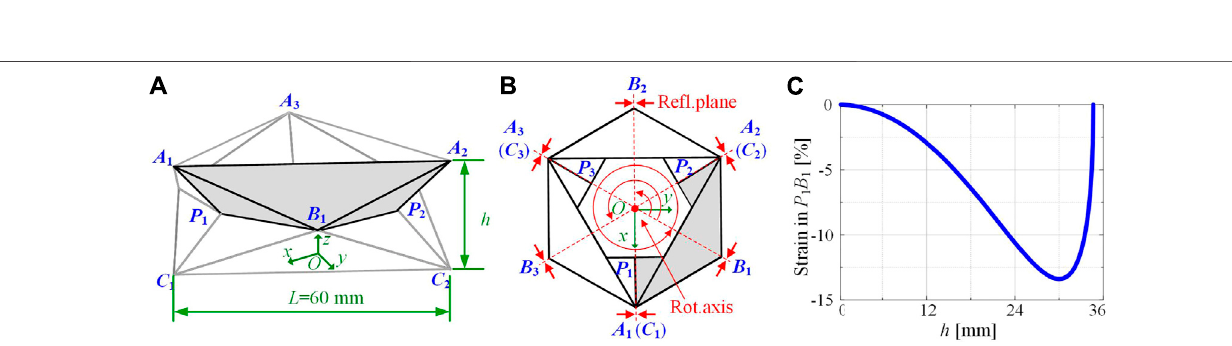
Frontiers in Robotics and AI |